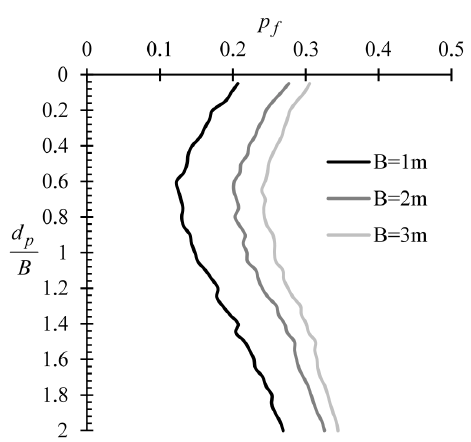
Figure 4. p f vs. d p / B example curves for θ = 10 m, x / B = 0 and di ff erent footing widths B . Figure 4. f p versus p d B example curves for θ = 10 m, x/B = 0 and different footing widths B .